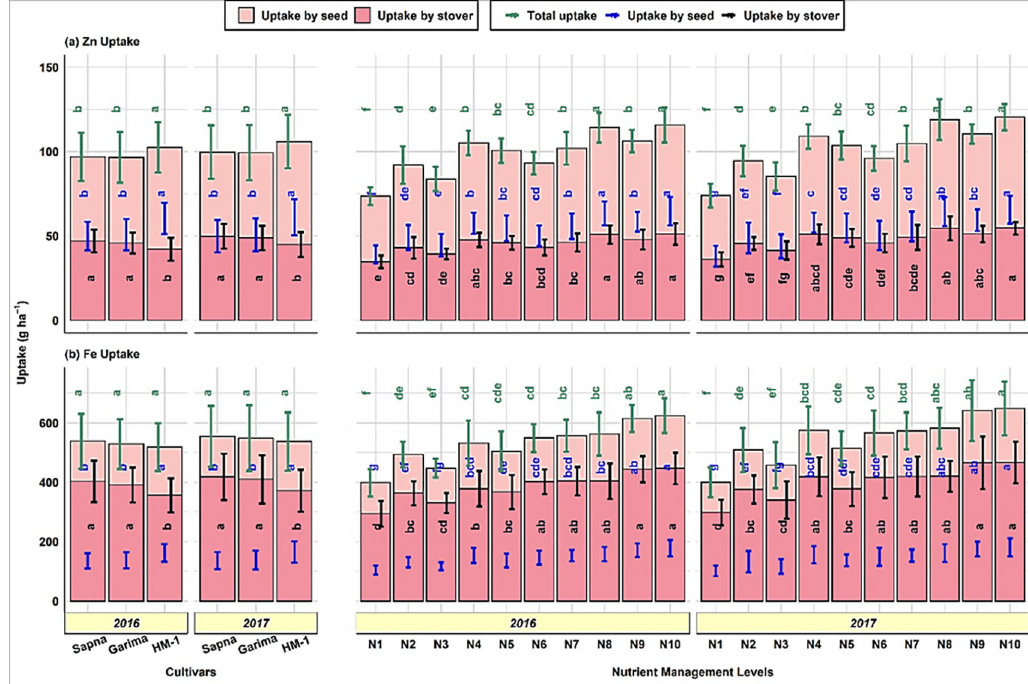
Fig 4. Total nutrient uptake (seed + stover) of lentil as influenced by cultivar selection and nutrient management